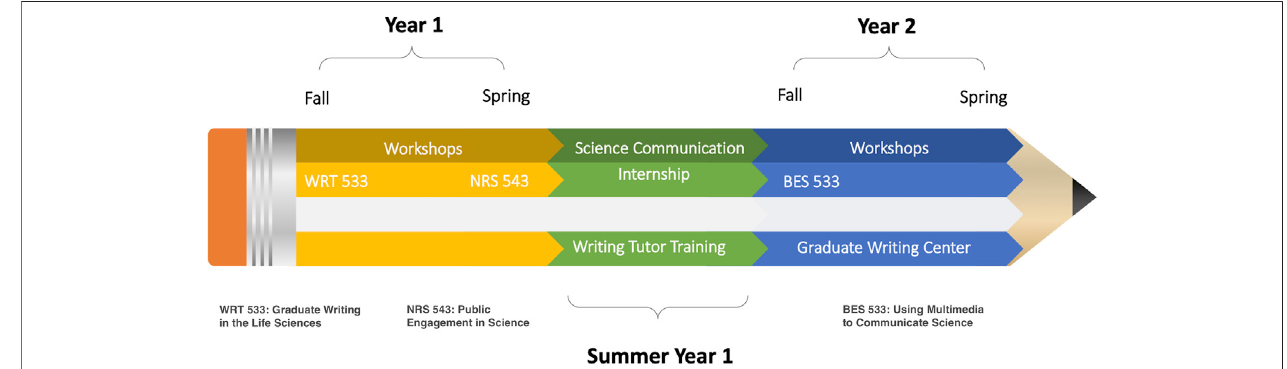
FIGURE 1 | Timeline of the 2-year SciWrite Program used to train each of the two cohorts of graduate students from 2016 to 2019: Progression through three courses (WRT 533 Graduate Writing in the Life Sciences, NRS 543 Public Engagement in Science, and BES 533 Using Multimedia to Communicate Science), simultaneous workshops, a summer internship and writing tutor training, and working as writing tutors at the Graduate Writing Center.